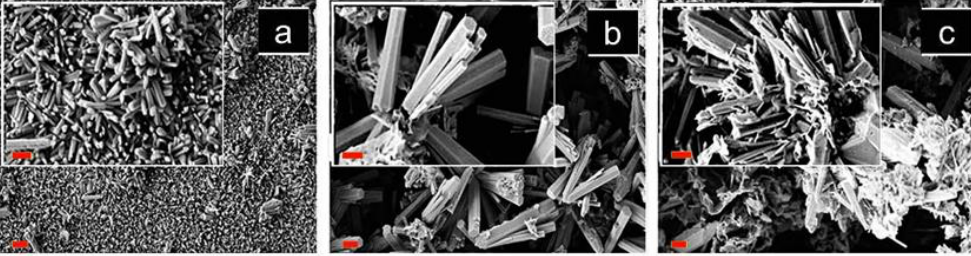
Figure 2. SEM images (scale bars: 2 μm) of the powder sample. ( a ) Undoped ZnO, ( b ) Ni-doped ZnO (5 at. %), and ( c ) Ni-doped ZnO (10 at. %). Note that in insets scale bars: 1 μm. Modified from reference [8].